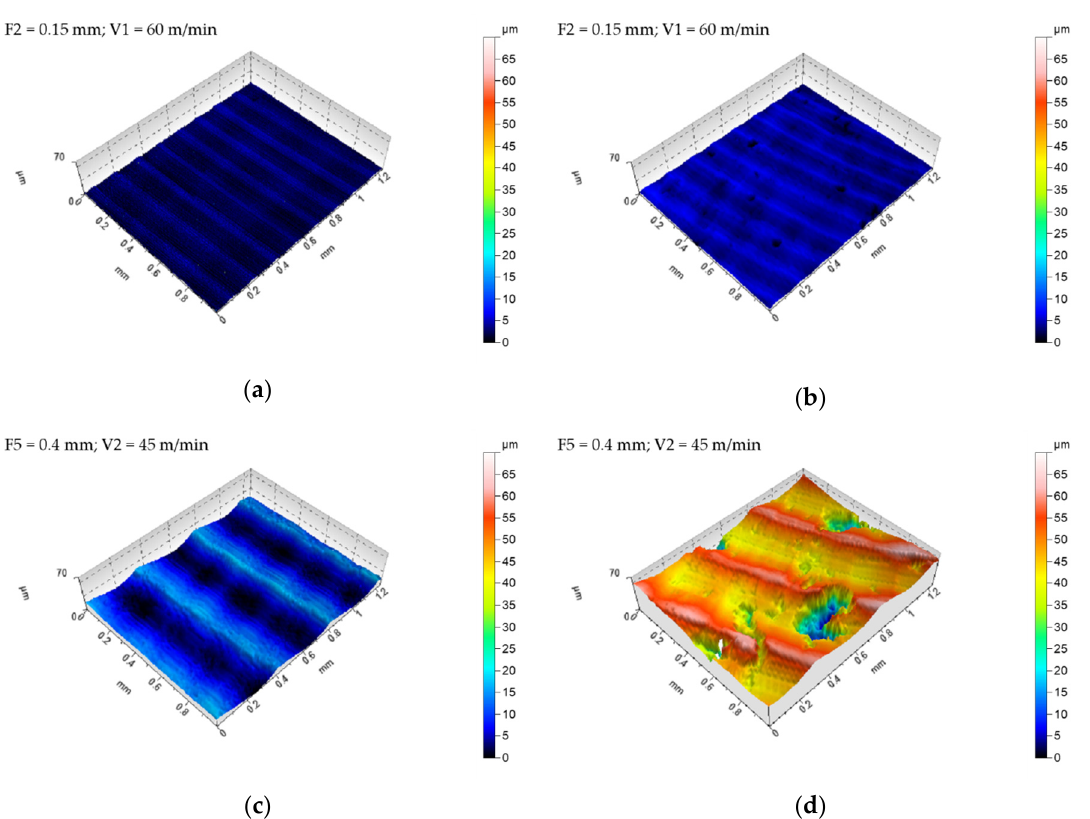
Figure 7. Isometric views of the surfaces machined with different technological parameters, i.e., F2 = 0.15 mm; V1 = 60 m/min and F5 = 0.4 mm; V2 = 45 m/min for: ( a , c ) cast sample; ( b , d ) SLM sample.